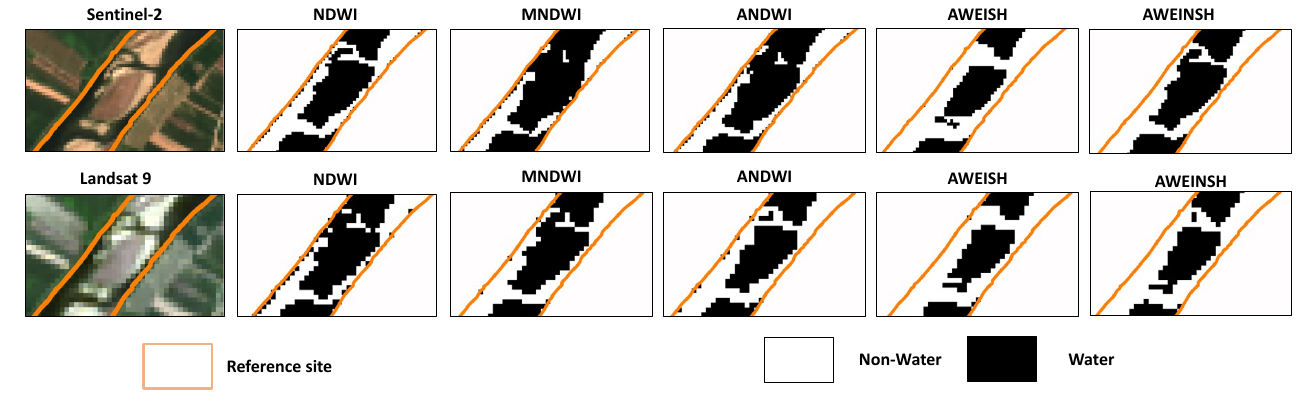
Figure 11. Detailed view of the river bed mapping in a section of the river dominated by the presence of a large single sandbar. The two panels more to left show 20 m Sentinel-2 RGB image ( top row ) and 30 m Landsat 9 RGB image ( bottom row ). The other panels show the corresponding mapping that resulted from the analysis of the five water indices (NDWI, MMNDWI, ANDWI, AWEInsh, AWEIsh) using the same criteria applied in Figures 9 and 10.